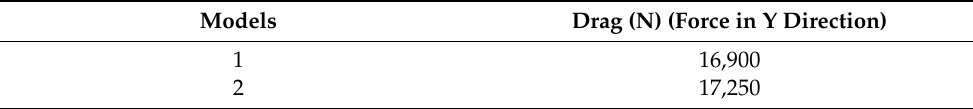
Table 4. Comparative report of